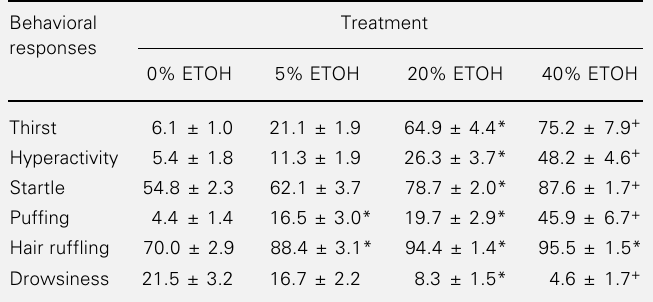
Table 1 - Mean week frequency of behavioral responses recorded 1 h after the removal of the alcohol solution.